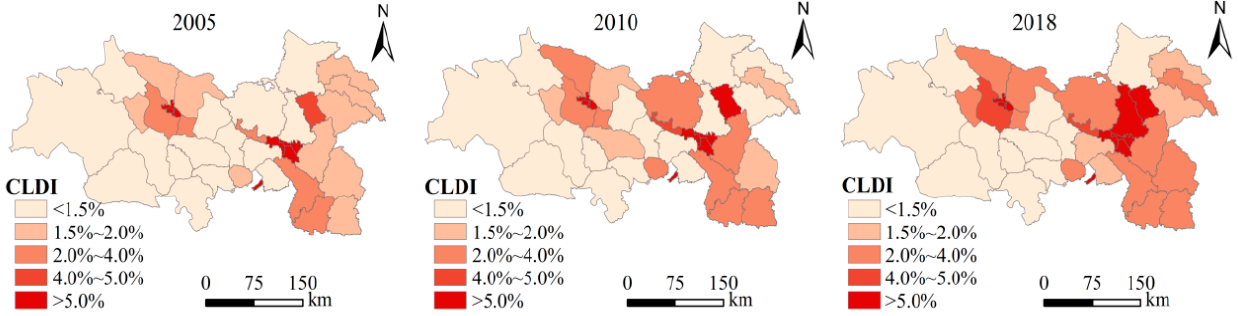
Figure 3. The spatial pattern of CLDI in LXUA.